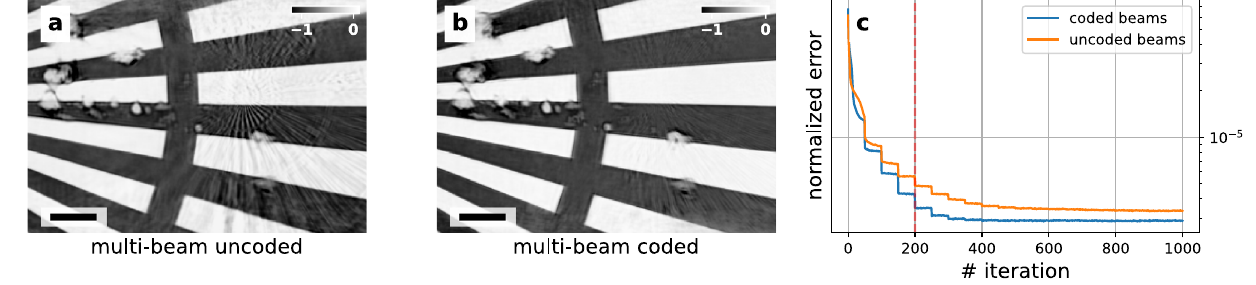
Figure 3. Cropped intermediate reconstruction results of the Siemens star after 200 iterations using ( a ) similar probes and ( b ) coded probes. The scale bars have a length of 1.5 μm. The grayscale indicates phase shift in radians. ( c ) Comparison of the evolution of the normalized error during the reconstruction of the scan of the Siemens star test sample with uncoded beams and coded beams. The sharp downward steps every 50 iterations are a result of the position correction being performed at these iterations.